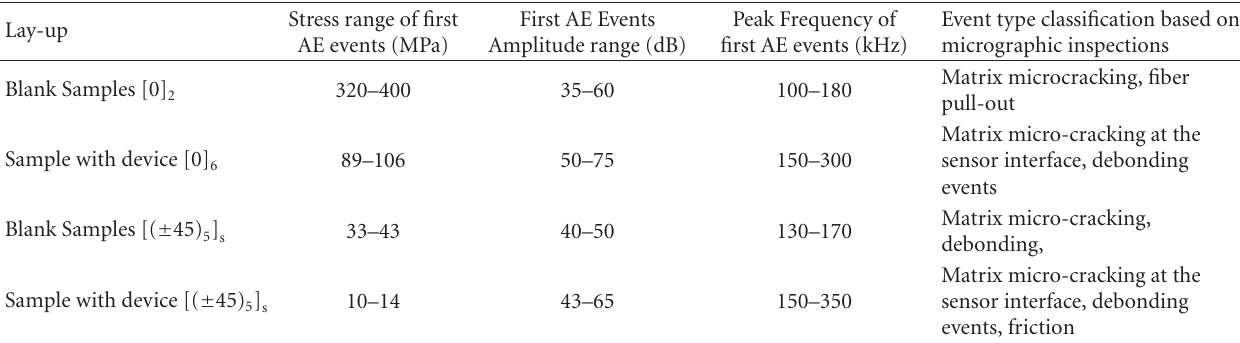
laminates [16] are here reported for comparison. n